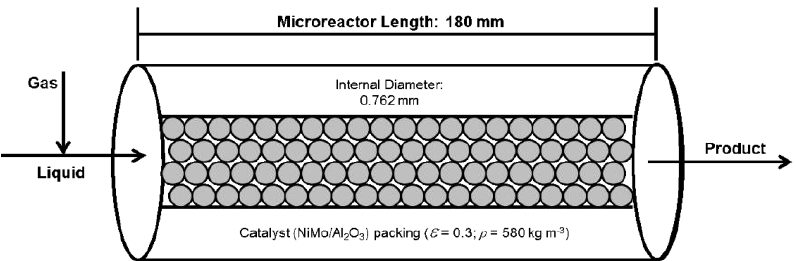
Figure 8. Schematic of the microreactor used for the implementation of the mathematical model.